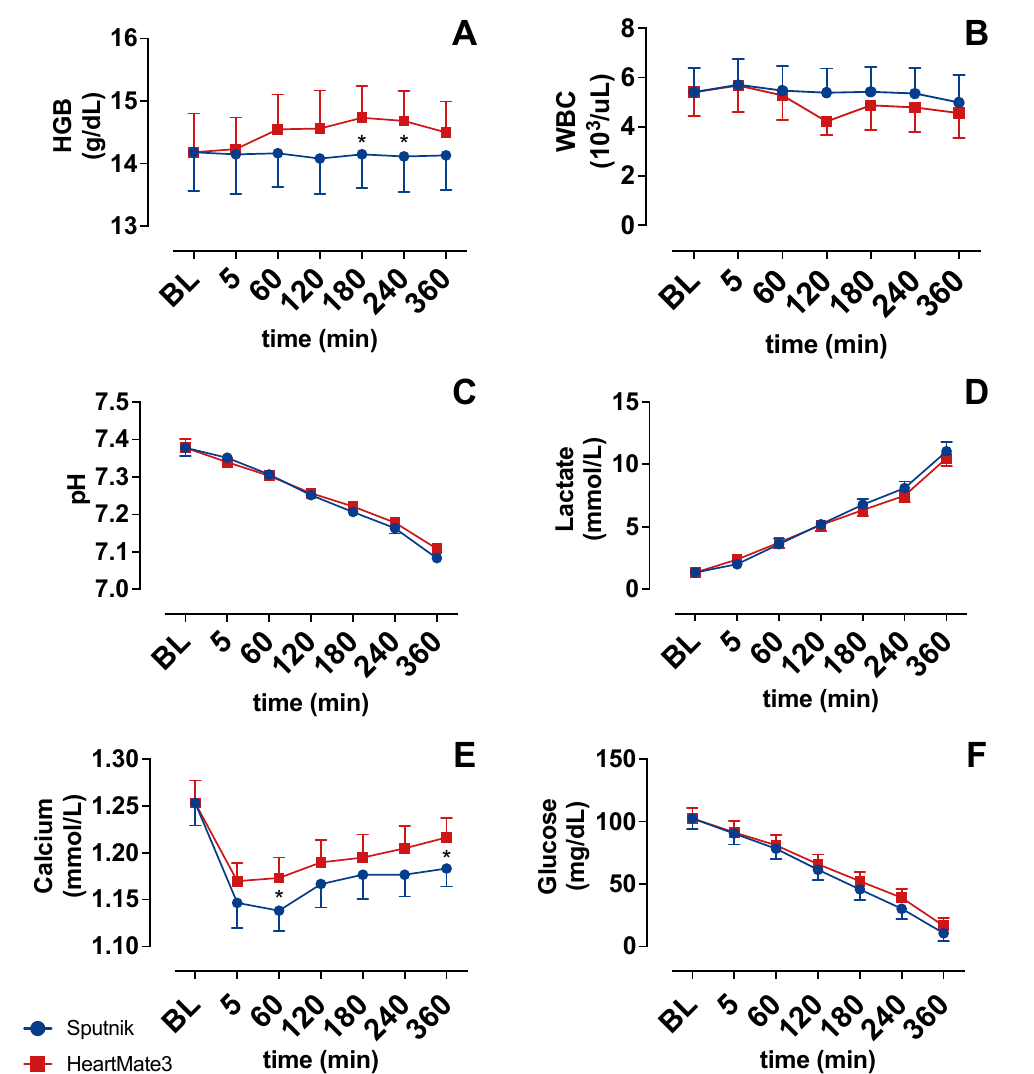
Figure 6. ( A ) Total hemoglobin (HGB), ( B ) white blood cell count, ( C ) pH value and ( D ) lactate concentration, ( E ) calcium concentration and ( F ) glucose concentration over time. Baseline (BL). * p < 0.05.